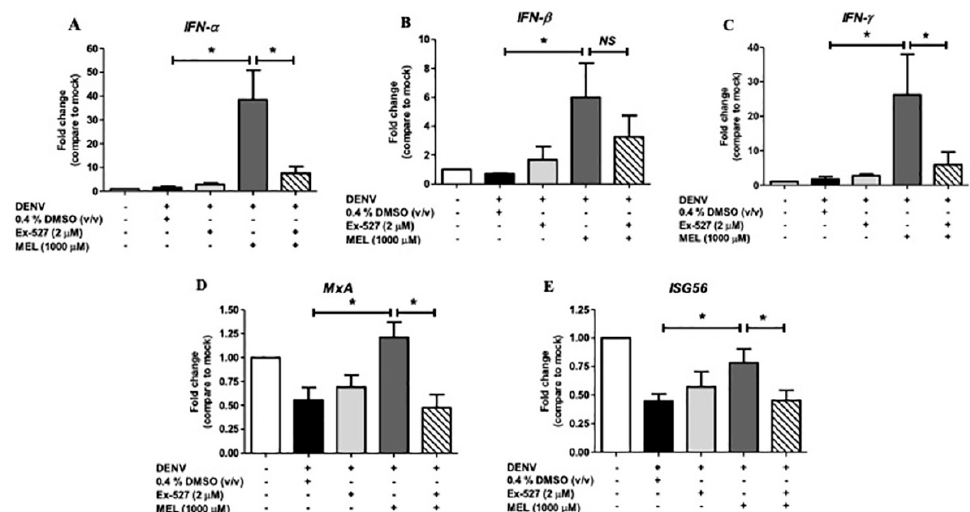
Figure 7. MEL enhances antiviral interferon (IFN) response via SIRT1 pathway. Huh7 cells were infected with DENV2 at MOI 1 and treated with MEL with and without EX-527. Cells were collected at 24 h pi and mRNA expression of antiviral genes was examined by real time RT-PCR. ( A ) IFN- α , ( B ) IFN- β , ( C ) IFN- γ , ( D ) MxA, and ( E ) ISG56. The asterisk (*) sign denotes p < 0.05 considered to be statistically significant.